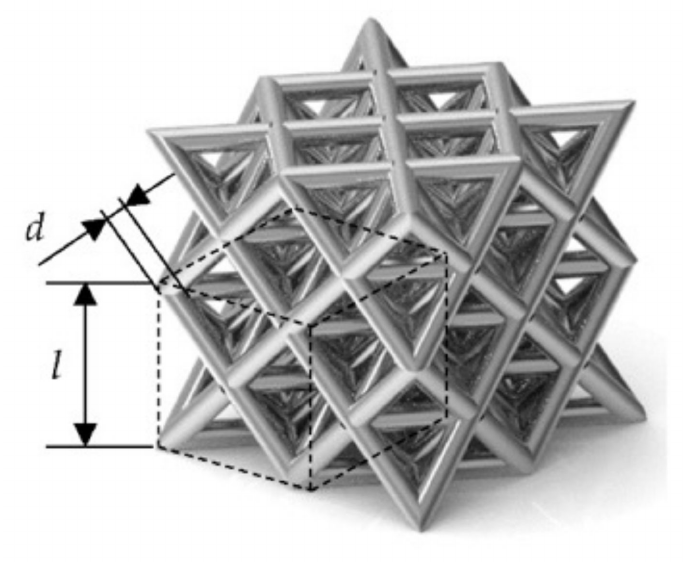
Figure 1. Example of the specimens subjected to compression tests with the cell unit cell geome- try highlighted.